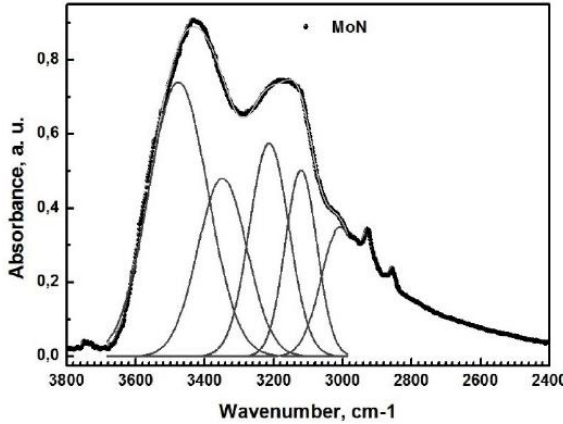
Fig. 5 represents the 2400-3800 cm −1 range of the molybdenum nitride spectrum. This proportion of the spectrum usually contains information about CH 2 /CH 3 groups, N- H liaisons, and O-H liaisons in H 2 O, respectively. As shown, the part relating to the N- H signature [33] is more pronounced and very clear in the MoN coating.